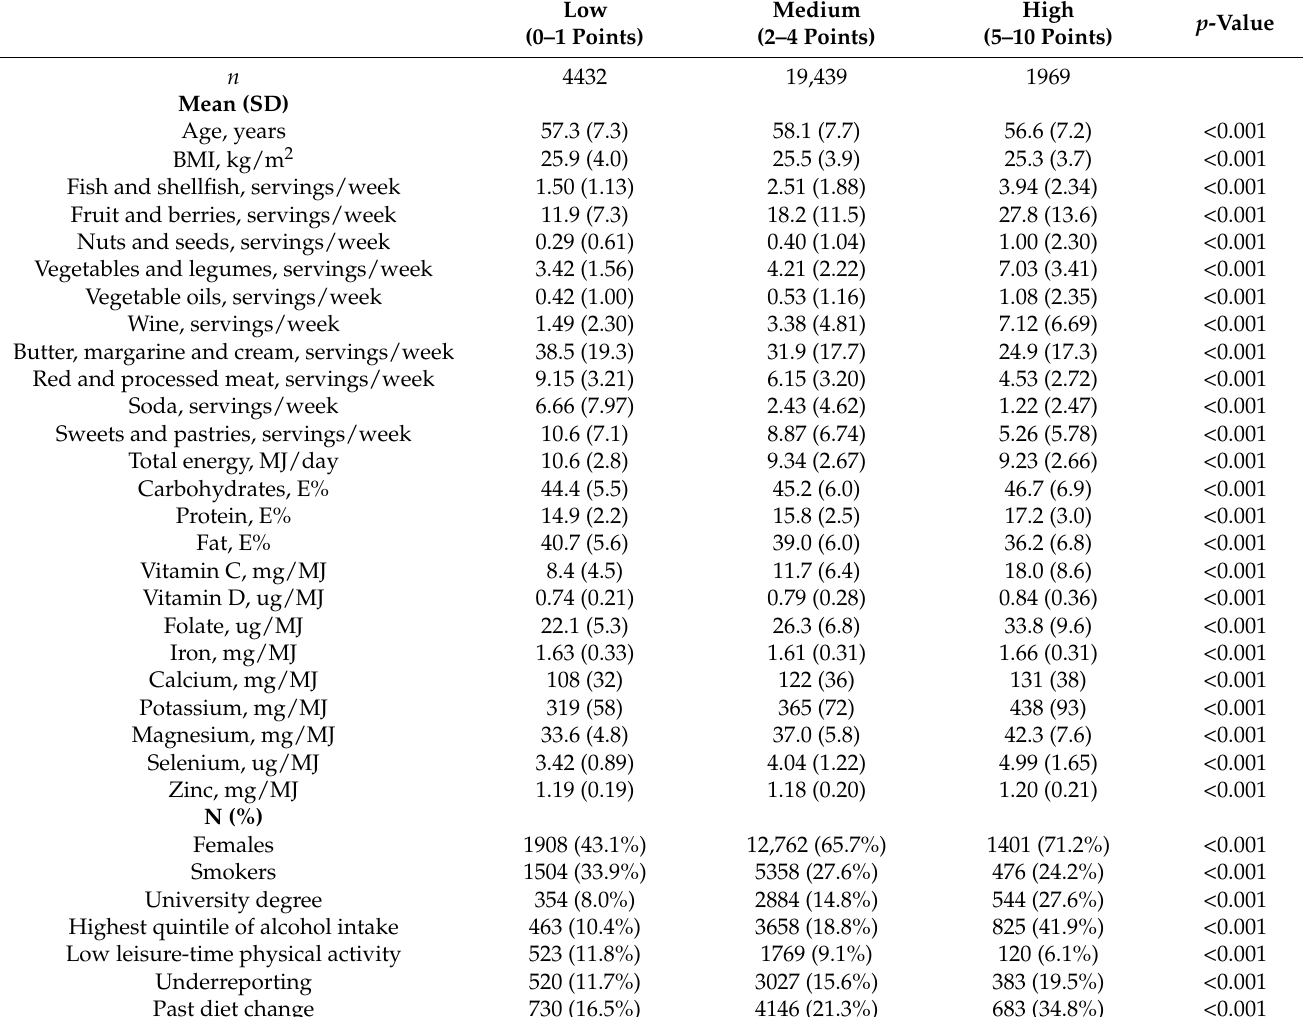
Table 2. Baseline characteristics across modified Mediterranean diet score (mMDS) adherence